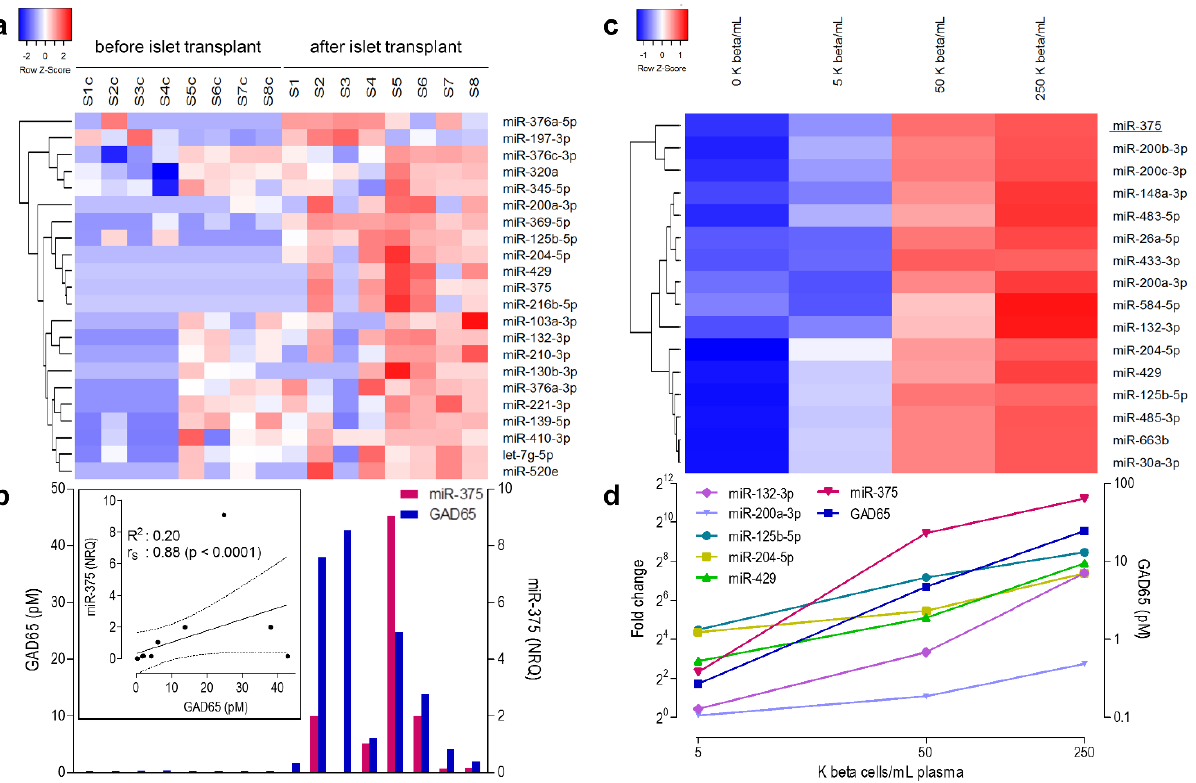
Figure 2. microRNA profiling after islet cell transplantation and beta cell recovery experiment. A total of 733 human microRNAs were measured before and 1 h after intraportal islet cell transplantation in a discovery cohort of 8 transplant events. ( a ). Twnety-two microRNAs showed at least 4-fold increase after islet cell transplantation. Log(NRQ) values were hierarchically clustered and for every microRNA the row z-score is shown. Sc/S indicates the paired samples before and after islet infusion. ( b ) . Bar graphs indicate the GAD65 (pM) and miR-375 (NRQ) levels before and one hour after islet cell transplantation and their linear correlation (Inset, r S = 0.88; p < 0.0001). The full line represents a regression line and the dashed lines their 95% confidence interval. ( c ). Sixteen microRNAs increased linearly after spiking of ascending amounts of human beta cell lysate to a healthy control plasma pool (0 K beta cells/mL; 5 K beta cells/mL; 50 K beta cells/mL and 250 K beta cells/mL, 1 K = 10 [3] beta cells). Log (NRQ) values were hierarchically clustered (color key according to z score). ( d ). Fold change with control levels (2 ΔCt ) are shown versus the number of spiked beta cells (log-scale).